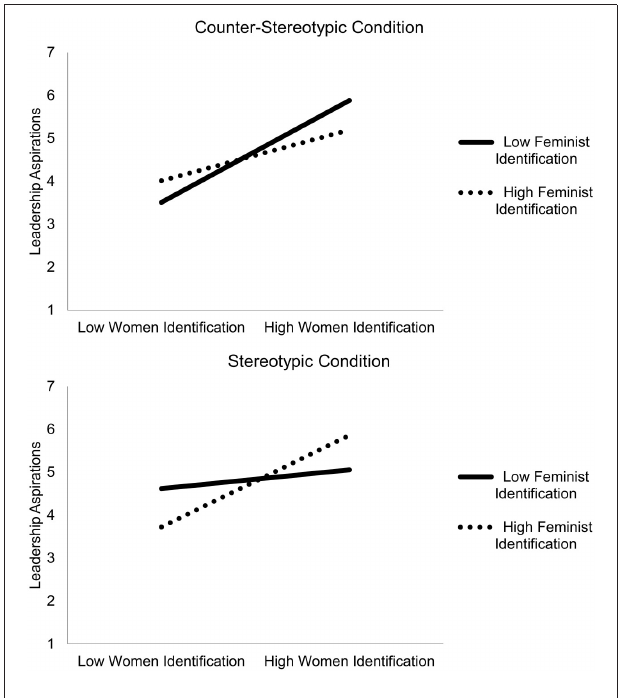
FIGURE 1 | Leadership aspirations as a function of feminist and women identification in the counter-stereotypic condition (upper) and in the stereotypic condition (lower)